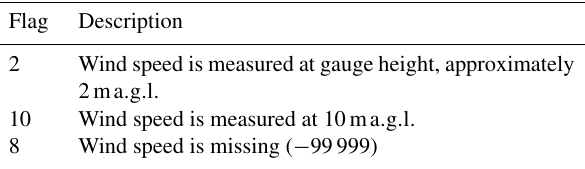
Table 3. Wind speed measurement flags (column 5).